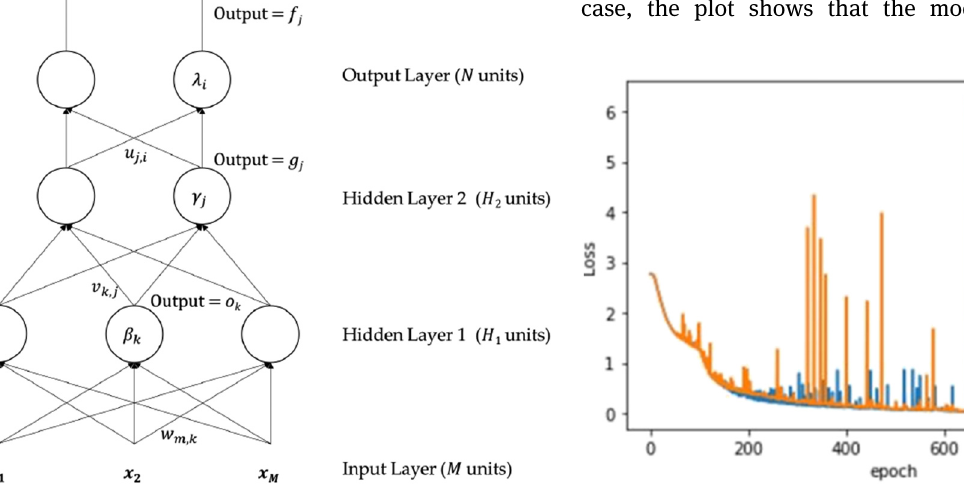
Figure 5: Typical con fi guration of DNN. Figure 6: Plot for optimization performed by